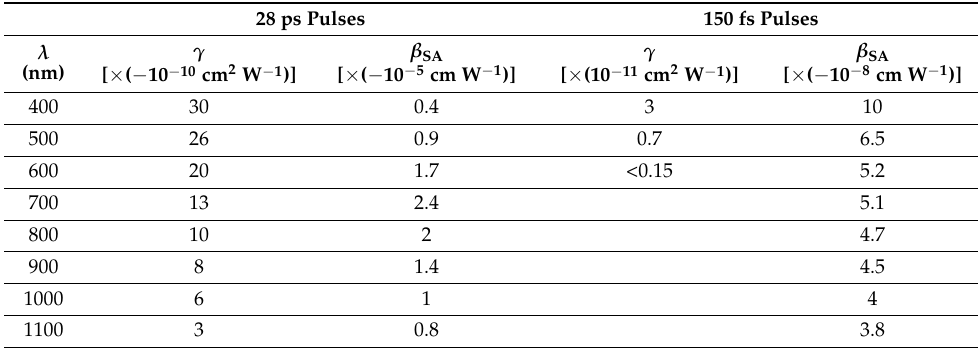
Table 3. The nonlinear optical parameters of the MTQD film.